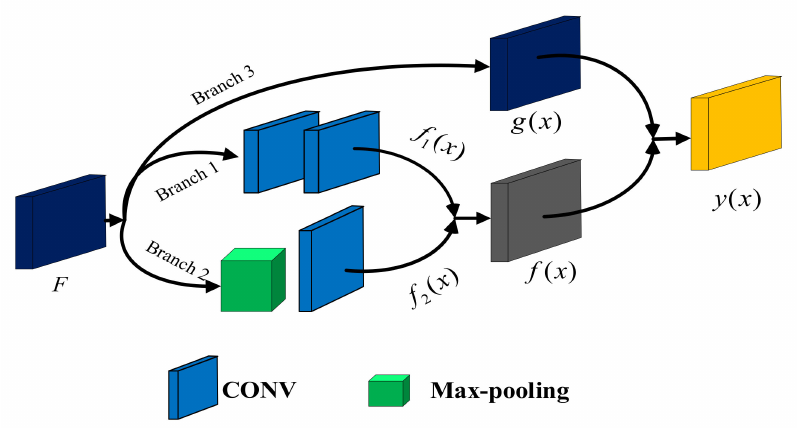
Figure 3. Three-branch shallow downsampling